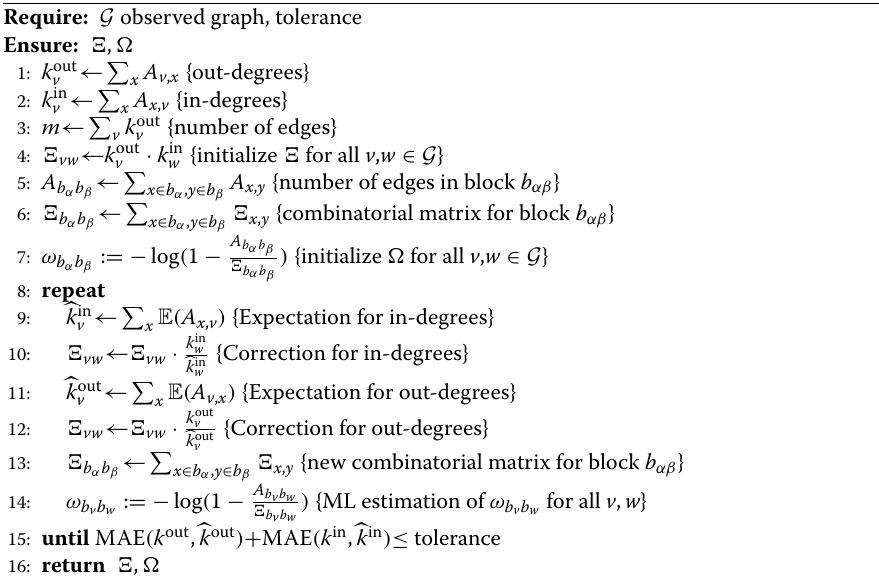
Algorithm 1 estimateBCCM( G , tolerance): Adjust entries of (cid:3) to match expected degrees (based on (cid:3) , (cid:4) ) to observed degrees (based on G ), within ‘tolerance’ error, where the error is computed as the mean absolute error